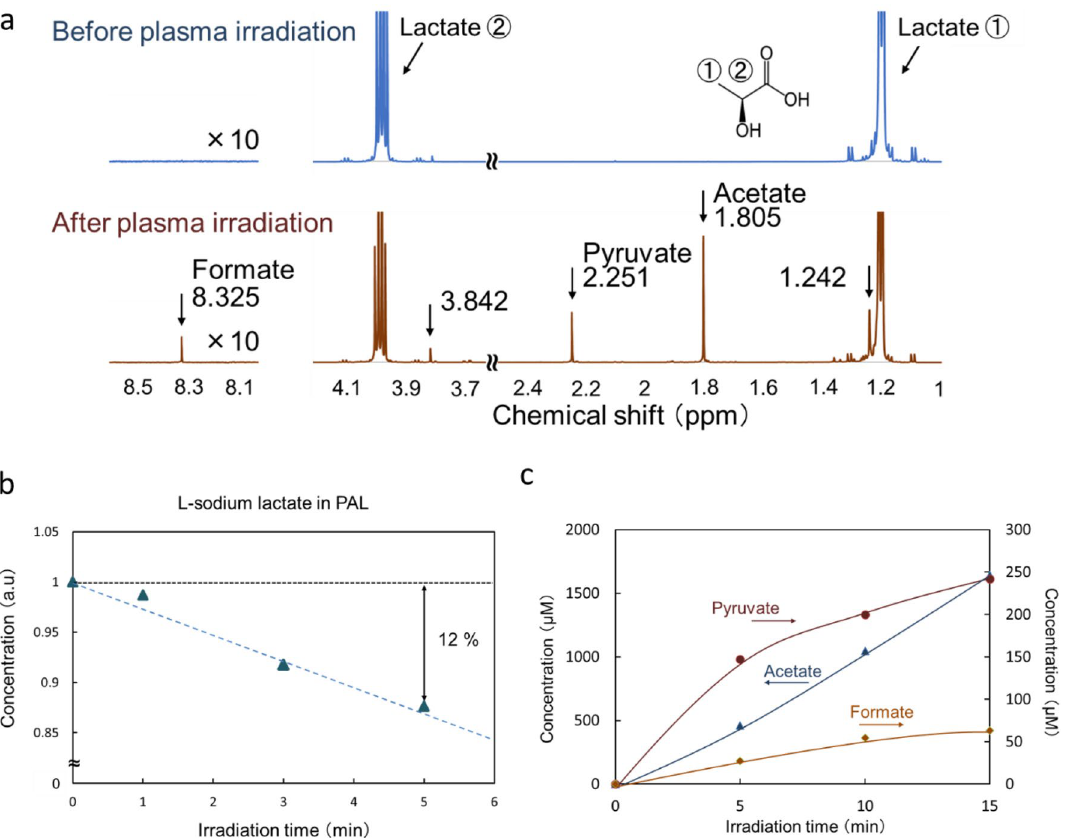
Figure 2. NMR analysis of PAL. ( a ) Chemical shift before and after plasma irradiation when L-sodium lactate was treated with LTP for 5 min. ( b ) The consumption rate of L-sodium lactate increases with increasing irradiation time of the plasma treatment. ( c ) The concentrations of pyruvate, acetate, and formate increase with increasing irradiation time of the plasma